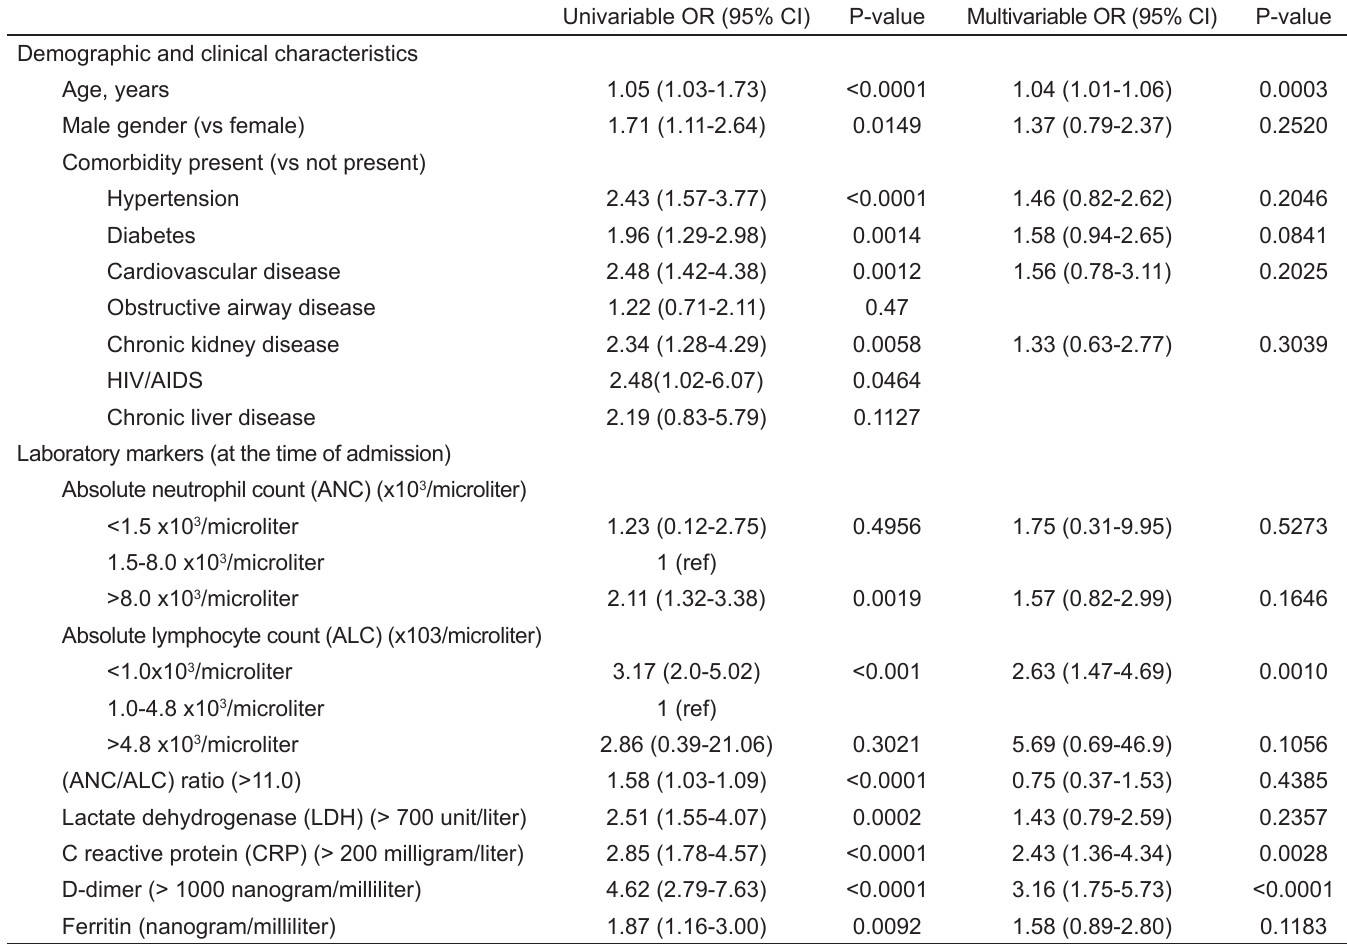
Table 2. Multivariable analysis of baseline characteristics of hospitalized patients diagnosed with coronavirus disease 2019 (COVID-19).